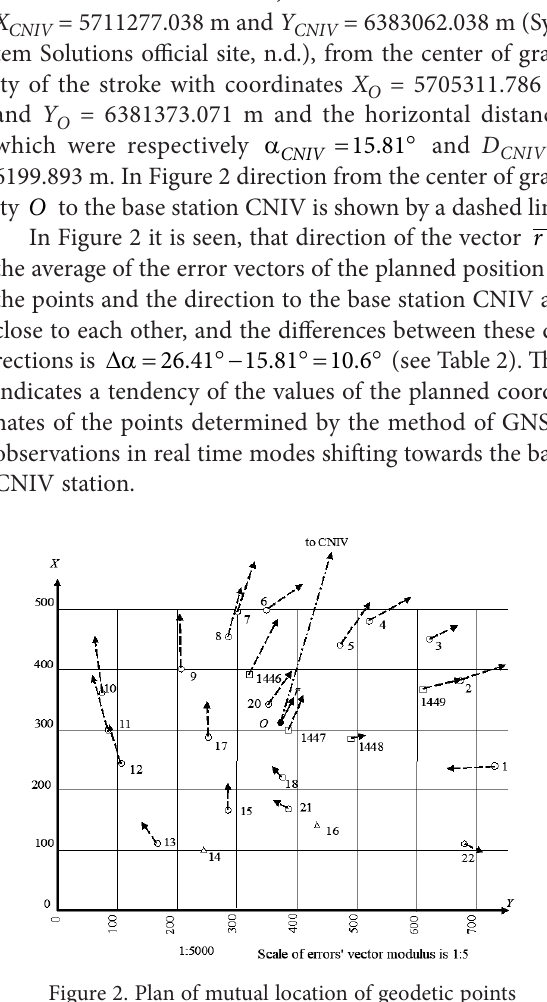
Figure 2. Plan of mutual location of geodetic points of the educational and scientific site “Fortuna” and vectors of errors of